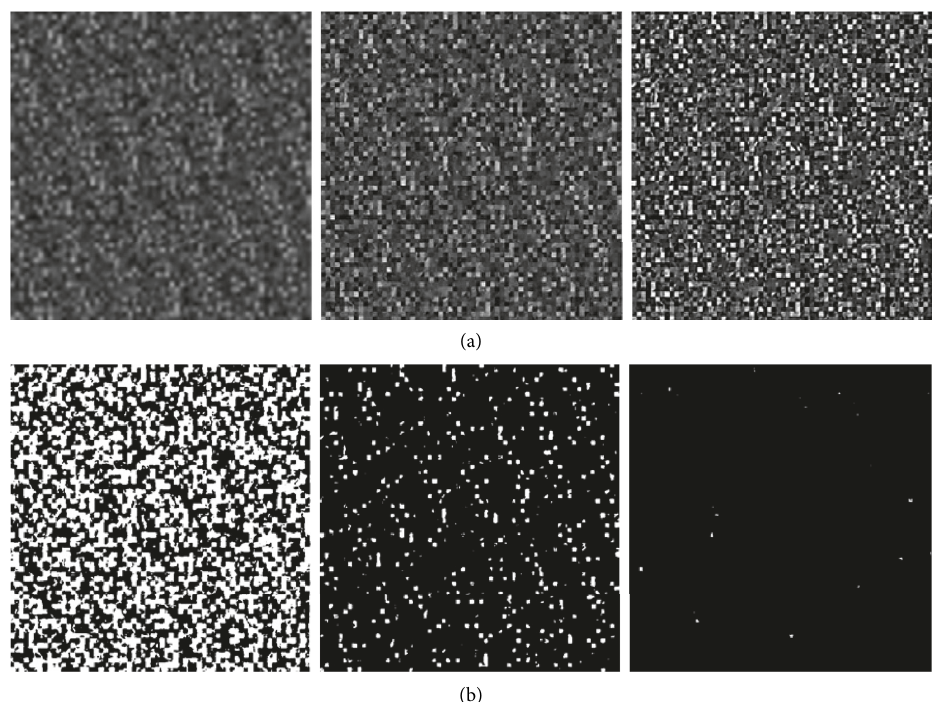
Figure 4: Comparisonof midpoint filtering results of images under different template sizes. (a) SEM image: from left to right, filter mask sizes are 3 × 3, 5 × 5, and 7 × 7, respectively, and (b) FIB/SEM images: from left to right, the filter mask sizes are 3 × 3, 5 × 5, and 7 × 7,